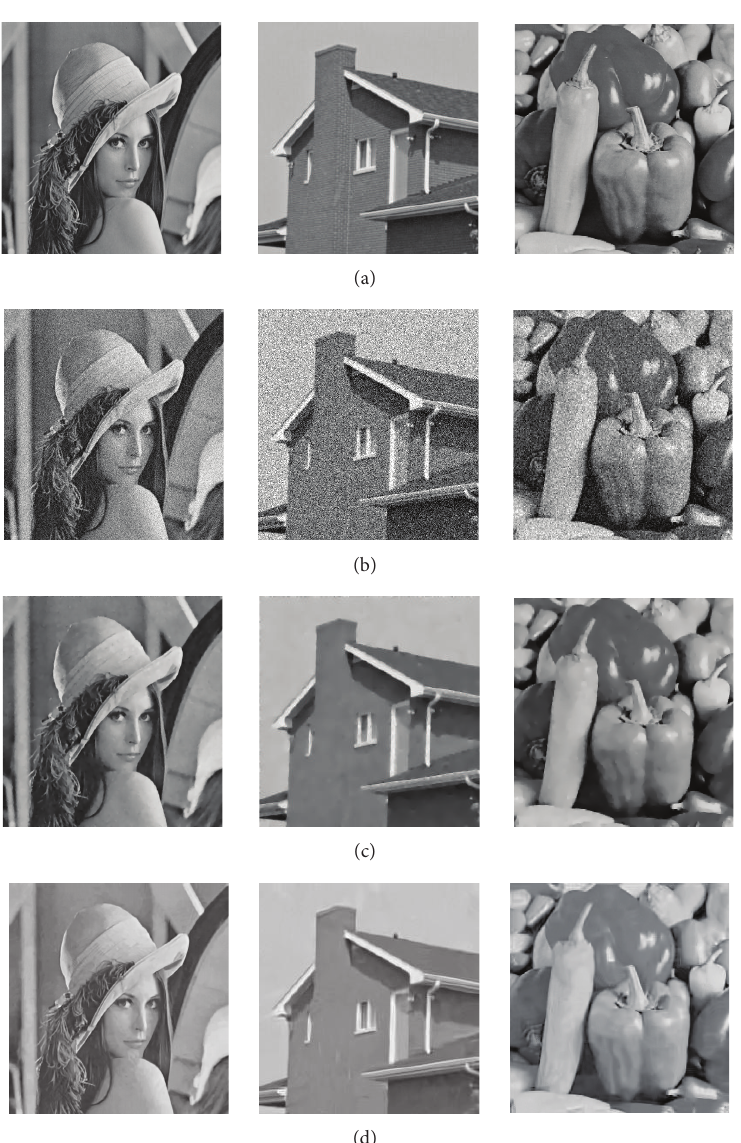
Figure 8: Results of our model and BM3D: (a) original image, (b) noisy image with the mean value of 0 and standard deviation of 𝜎 = 30, (c) results by our model, and (d) results by BM3D.